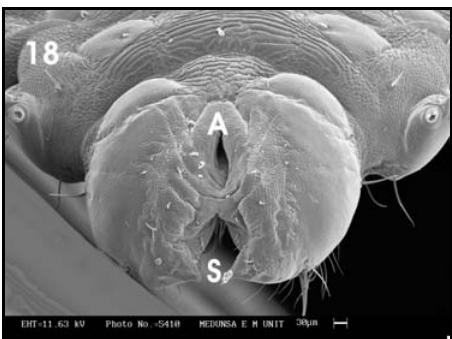
Fig. 18. The anal opening (A) above the sexual ori- fice (S).